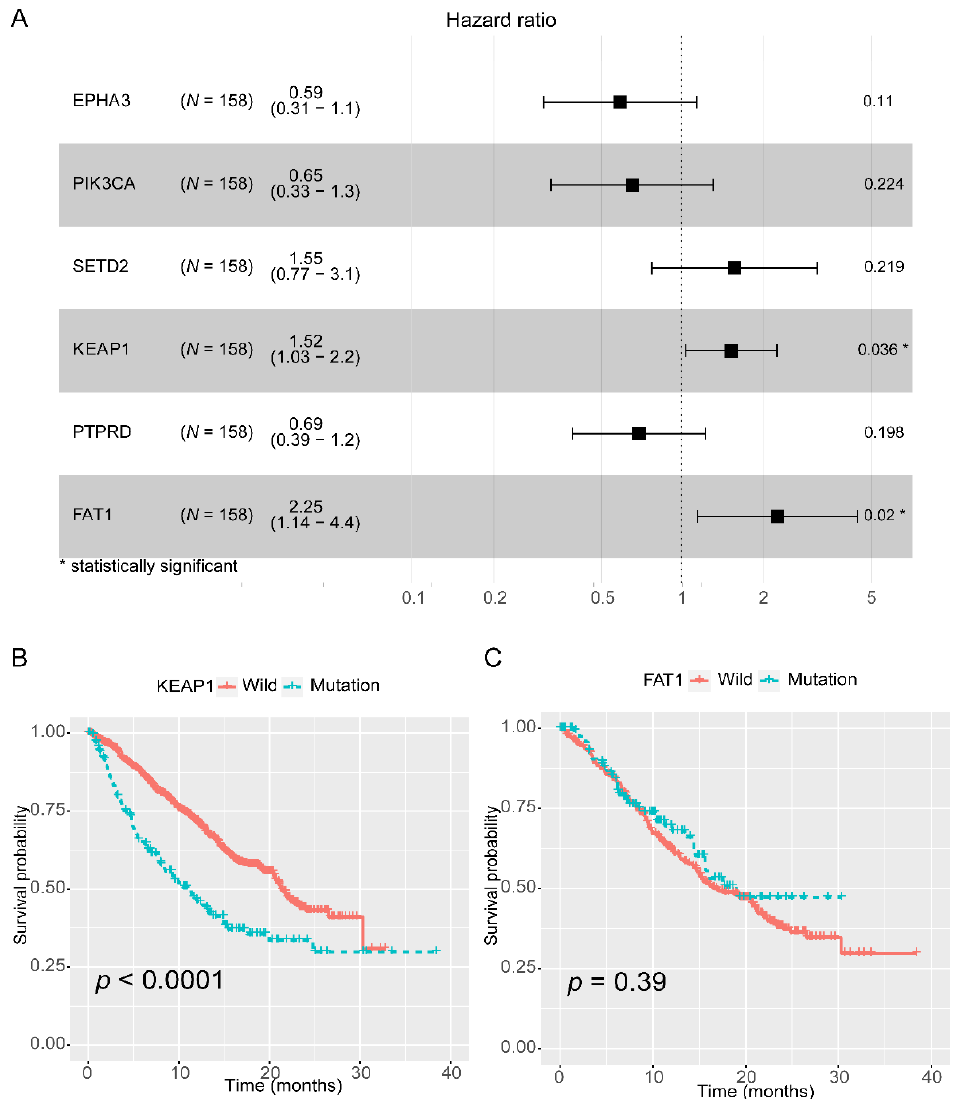
Figure 1. ( A ) Cox proportional hazard analysis to model association of mutations in KEAP1 and FAT1 with prognosis in patients who showed no durable clinical benefit (NDB) to treatment with immune checkpoint blockade (ICB). ( B ) The survival curve for OS (Overall Survival) according to the KEAP1 mutation status in the Zehir cohort. ( C ) The survival curve for OS according to the FAT1 mutation status in the Zehir cohort.